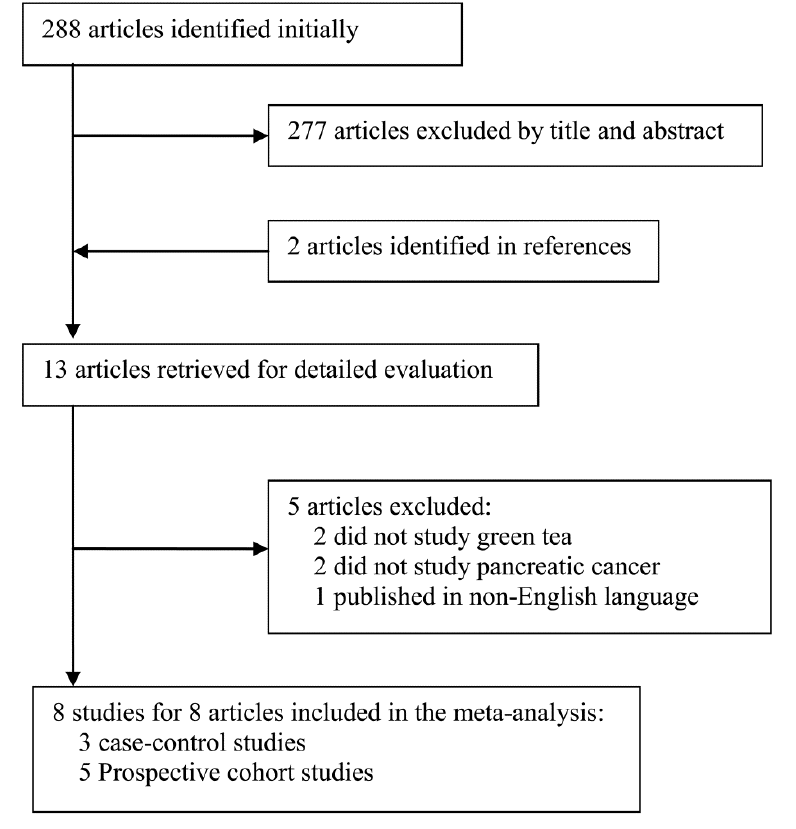
Figure 1. Selection of studies for inclusion in the meta-